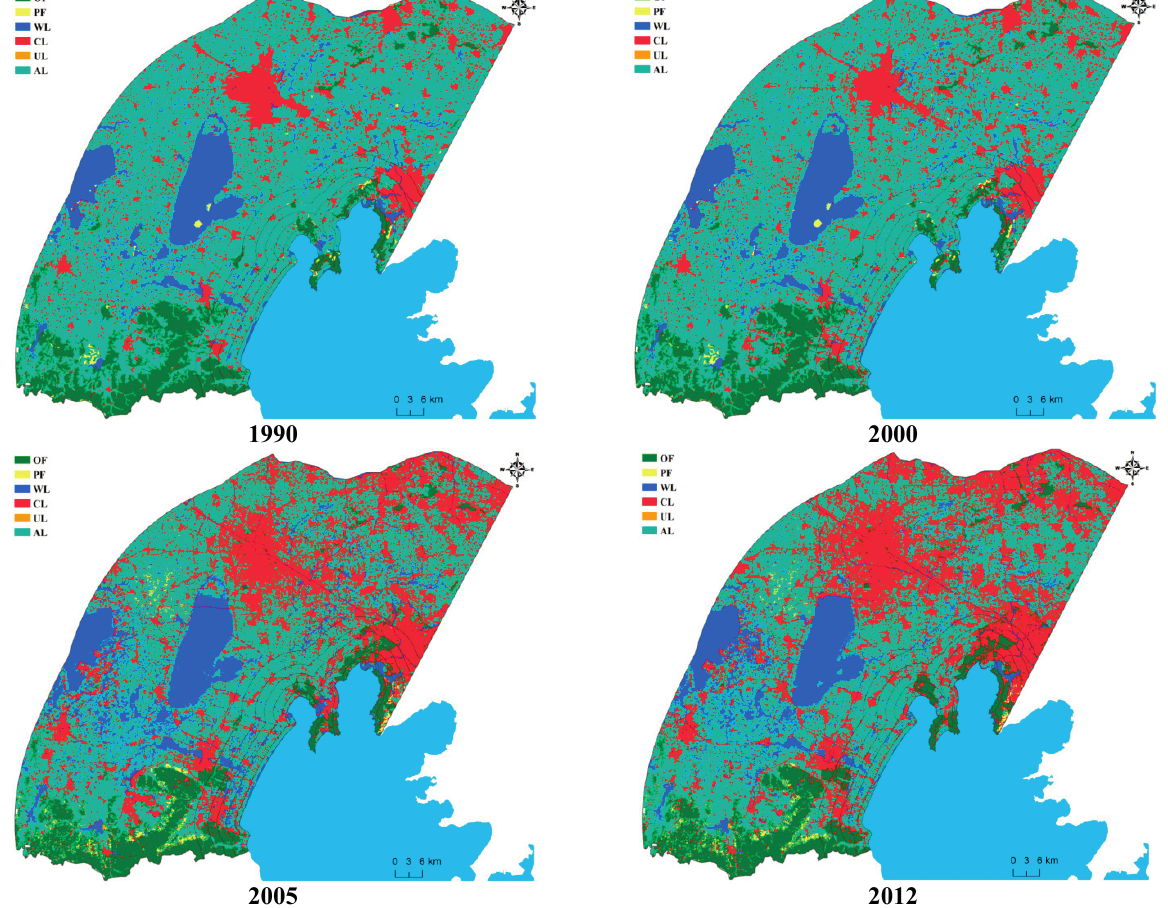
Figure 2. The tendency of Land Use/Cover change (LUCC) over of each buffer regions since 1990–2012. In 2012, construction land and agricultural land covered most of the region; the proportions of these two types exceeded 75% in ML (Table 1). In addition, the areas of wetland and original forestland were the third and fourth largest among all land use types. The original forest and planted forest increased since 2000, especially in the region close to Taihu Lake within WC and ML